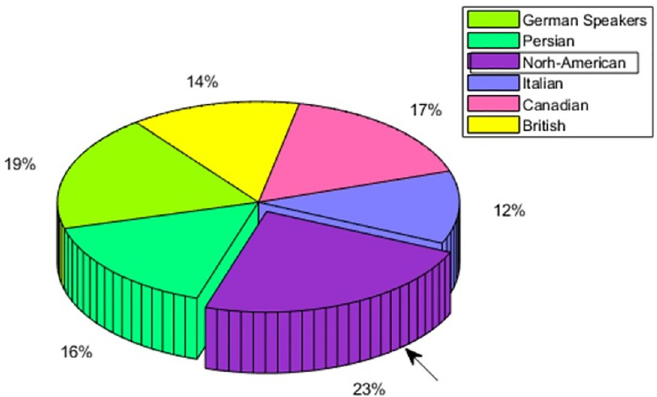
Fig 9. North-American speaker—Multicultural emotion accuracy comparison and In-group advantage.